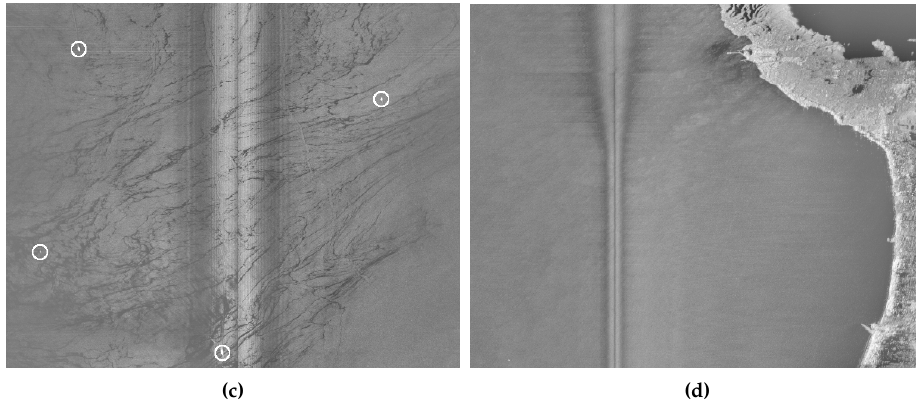
Figure 4. Examples of SLAR images from our dataset showing oil spills (marked with a bounding box), ships (small bright points marked with circles), look-alikes (elongated shapes in figures (b) and (c)), the noise produced by the sensor (the central vertical band that appears in all the images) and the aircraft maneuvers (the horizontal bands that appear in the upper part of figure (a)), and an example of coast (on the right side of figure (d)). Figures (c) and (d) do not contain any example of oil spills, however they have other artifacts that can lead to confusion.